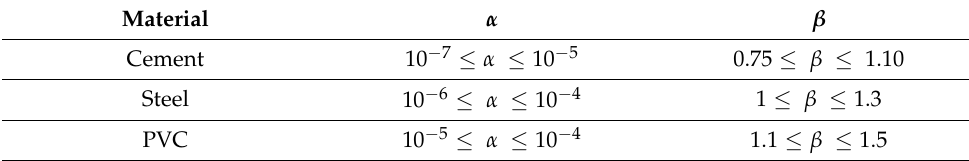
Table 1. Coefficients for different materials.